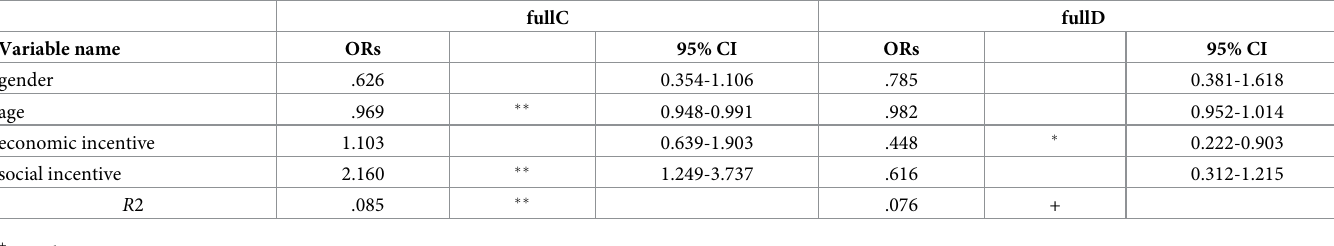
Table 1. Effect of incentives on full cooperation and defection.